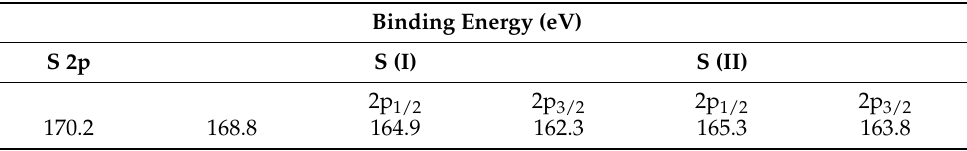
Table 3. Binding energy values of S 2p peaks in accordance with the deconvolution of XPS spectrum, as shown in Figure